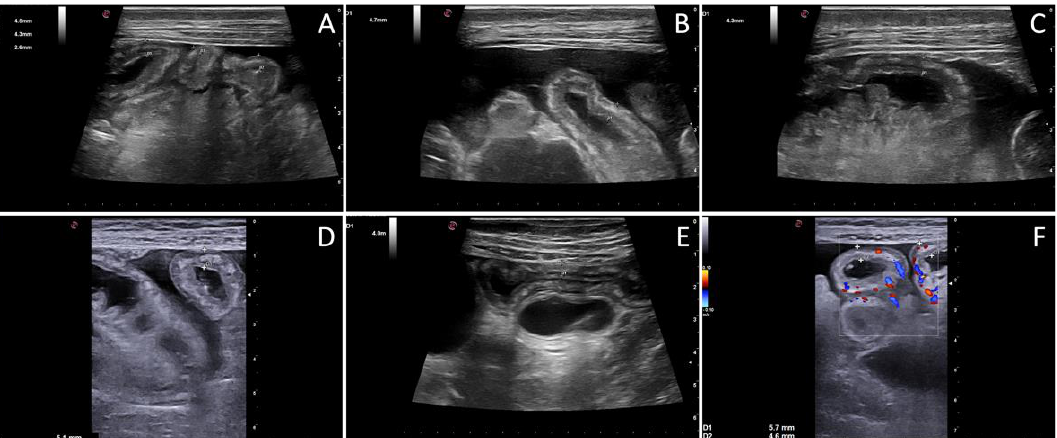
Figure 2. US and power Doppler findings in patient 2. ( A – C ) US findings at GvHD diagnosis: it is noticeable an increased BWT at colon level; moreover, boundaries between intestinal layers are poorly defined; ( D , E ) US at GvHD flare: increase in BWT at ileum level along with no definition in boundaries between intestinal layers; ( F ) strong increase in power Doppler at GvHD flare.